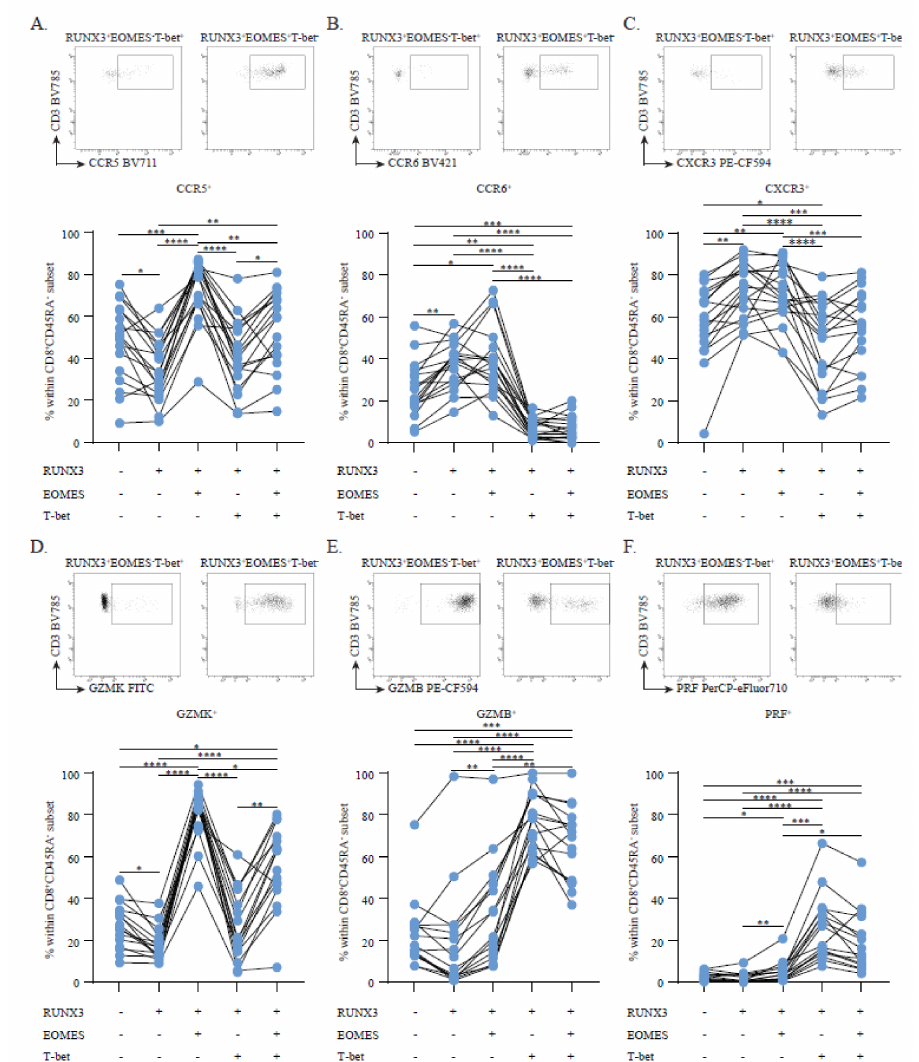
Figure 2. The influence of RUNX3, EOMES and T-bet on brain-homing and cytotoxic marker ex- pression. CCR5 ( A ), CCR6 ( B ), CXCR3 ( C ), GZMK ( D ), GZMB ( E ) and PRF ( F ) expression in the CD8 + memory T cell pool of treatment-naive MS patients ( n = 16–18) with RUNX3, EOMES and T-bet (co)expression. Above each graph a representative FACS plots shows the difference in marker expression between RUNX3 + cells expressing T-bet (left) and EOMES (right). Lines represent paired measurements from the same donor. Data were compared using a two-way ANOVA with FDR-BKY correction tests. * p < 0.05, ** p < 0.01, *** p < 0.001 and **** p <